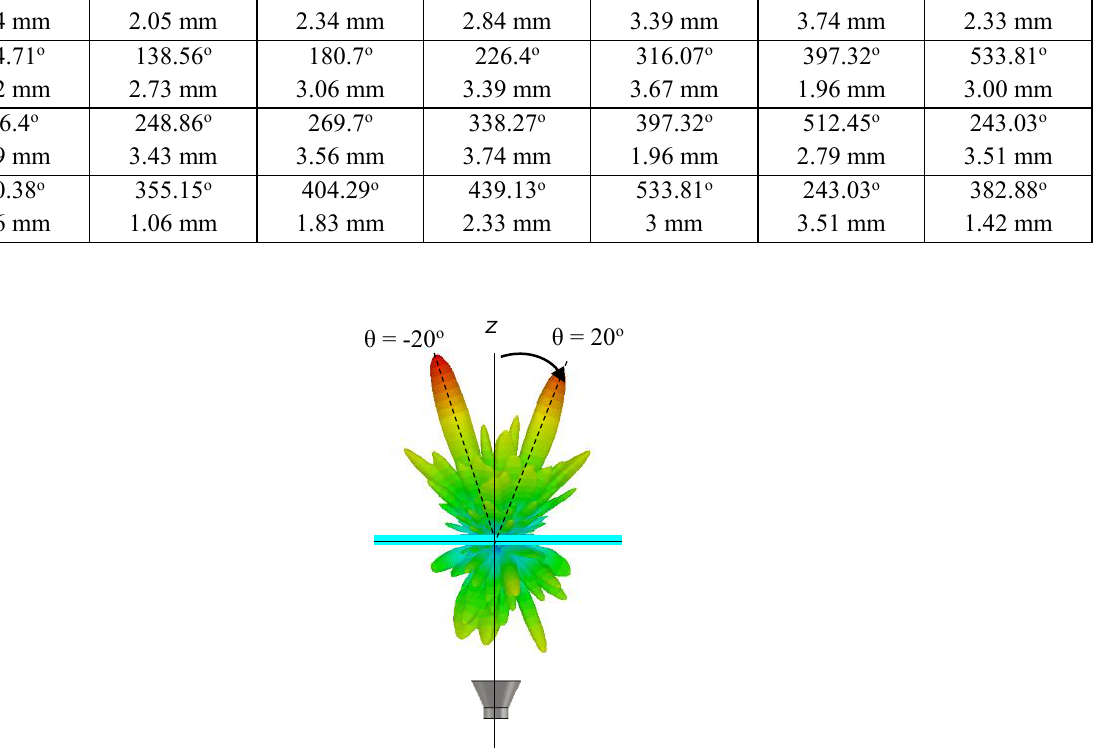
Table 3: The phase shift and the corresponding hole radius for NF/NF transmitarray (first quadrant). 306 o 317.56 o 353.92 o